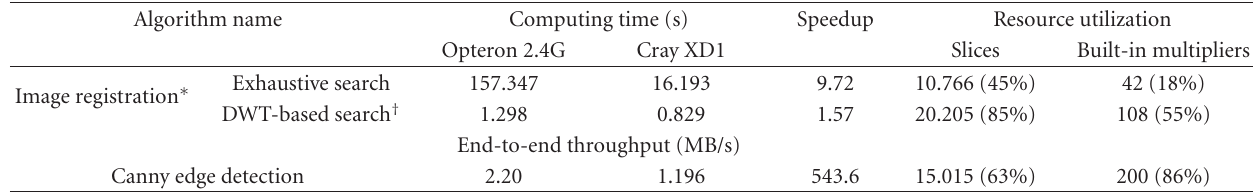
Table 2: Performance improvement of image registration and Canny edge detection on Cray